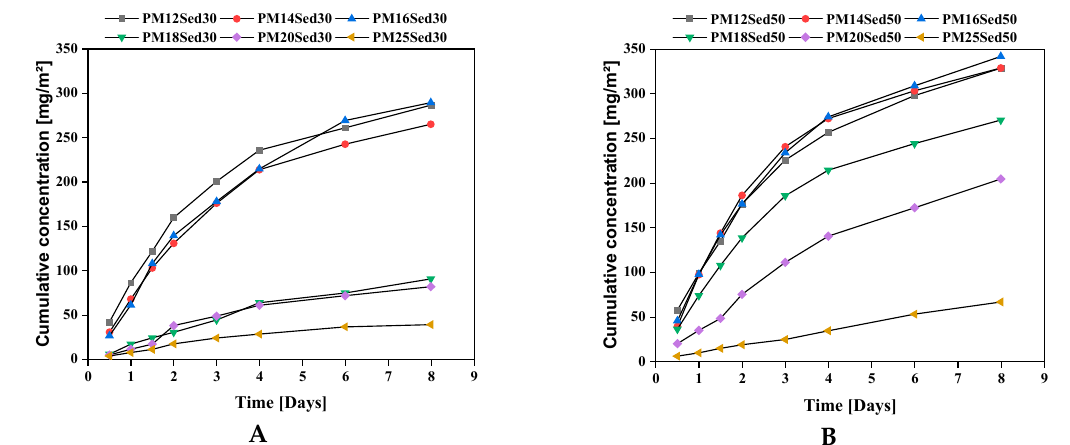
Figure 6. Evolution of cumulative concentration of potassium in leachates from monolithic polymer mortars containing 30% ( A ) and 50% ( B ) of sediments in their matrices.